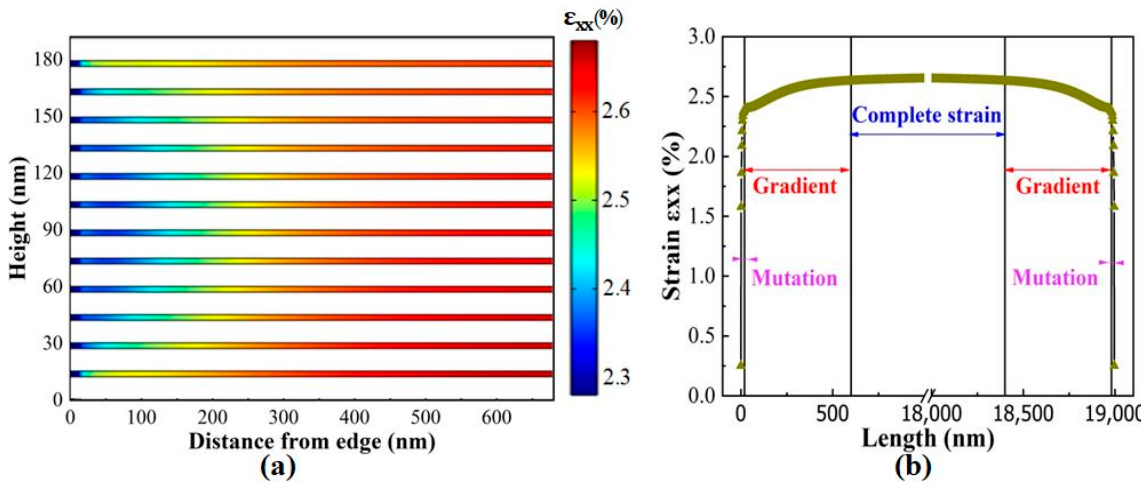
Figure 6. The simulated strain ( ε xx ) of In 0.25 Ga 0.75 N well layer with a diameter of 19 µ m GaN/InGaN pillar: ( a ) the strain distribution at the boundaries of the 12 quantum wells; ( b ) the division of strained regions after synthesizing 12 pairs of wells.